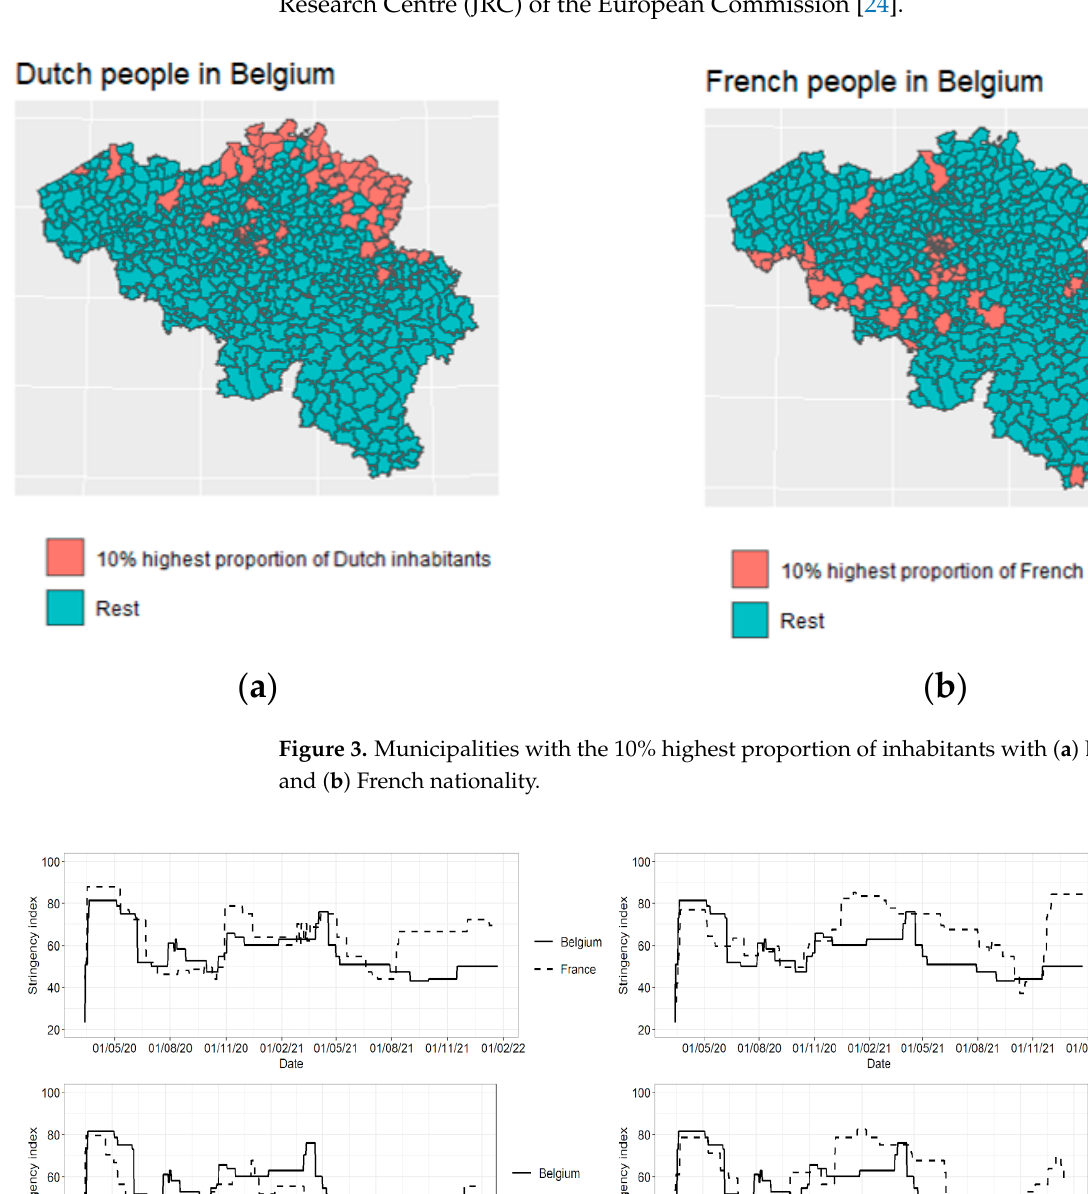
Netherlands. In Figure 5, a visualization is provided for a subset of NPIs implemented over time in Belgium and its neighboring countries, based on the Response Measures Database (RMD) of the European Centre for Disease Prevention and Control (ECDC) and the Joint Research Centre (JRC) of the European Commission [24].